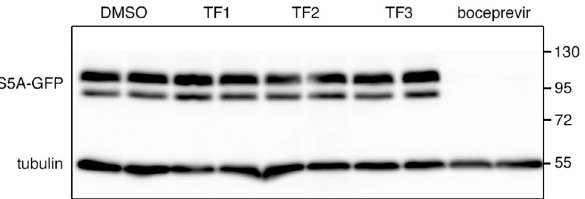
Fig 4. Theaflavins are not inhibitors of HCV replication. Huh-7 cells expressing a HCV replicon containing a GFP- tagged NS5A were incubated in the absence (DMSO) or presence of theaflavins at 25 μ g/ml, or Bocebrevir at 1 μ M, for 72 h. Cells were lysed and Western blot analysis was performed to detected NS5A-GFP and tubulin with specific antibodies. Data are representative of 3 independent experiments.